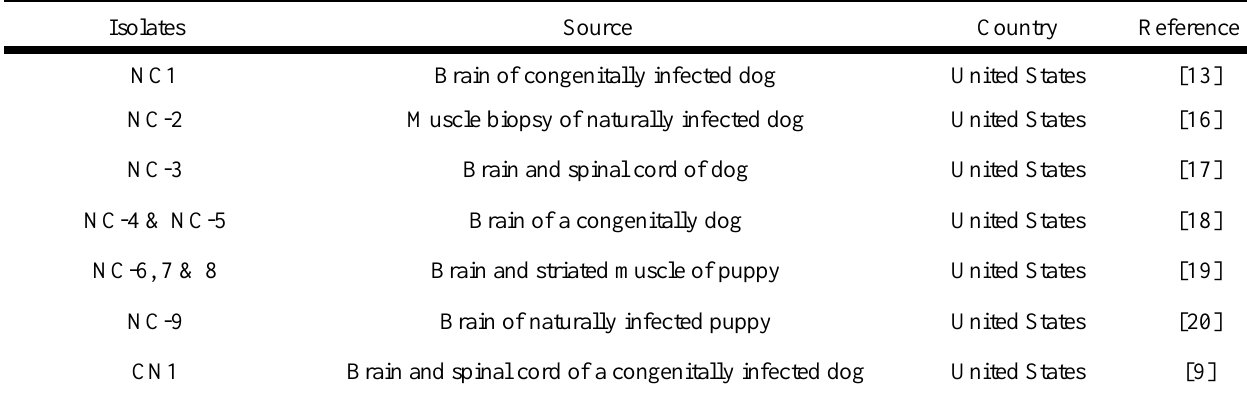
Table 1. Summary of Neospora caninum isolates from different host